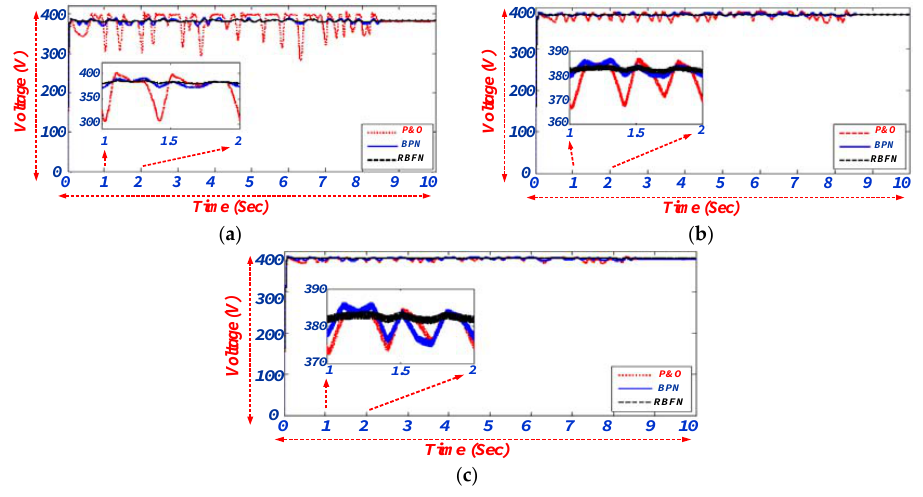
Figure 10. Voltage output of the WECS for ( a ) boost converter; ( b ) SEPIC converter; and ( c ) quadratic Boost converter with P&O, Back propagation network (BPN) and RBFN MPPT techniques. Electronics 2018 , 7 , x FOR PEER REVIEW 13 of 17